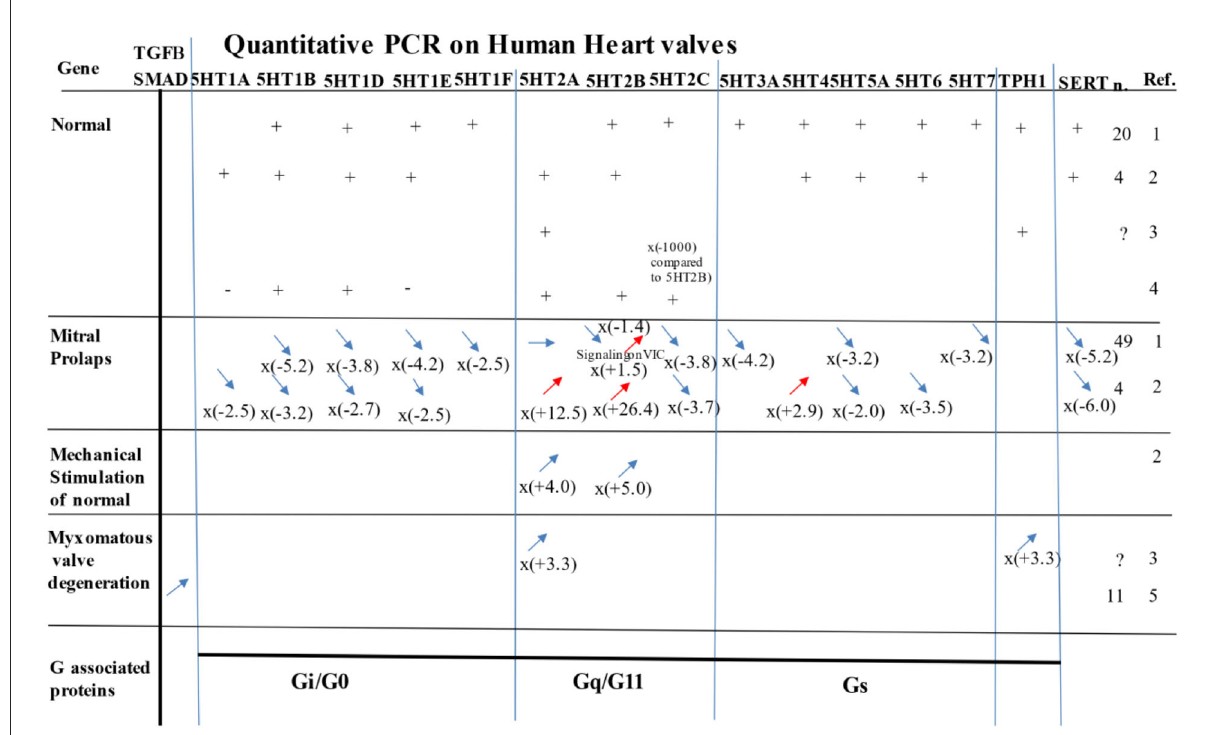
FIGURE4 Most significant study results evaluating expression of 5-HTRS, TPH1, or SCC6 (i.e., the gene for SERT) by PCR on human samples in normal, prolapse, myxomatous degenerative valves, or under mechanical stimulation. n = number of samples analyzed. For PCR quantification for mitral prolapse and myxomatous valve degeneration, the values are compared to the normal. Ref. references for this figure/ 1) Levy et al. (5); 2) Driesbaugh et al. (2); 3) Hulin et al. (25); 4) Roy et al. (27); 5) Sainger et al. (28). See also for review: Ayme-Dietrich et al. (3) and Barnes et al. (11,